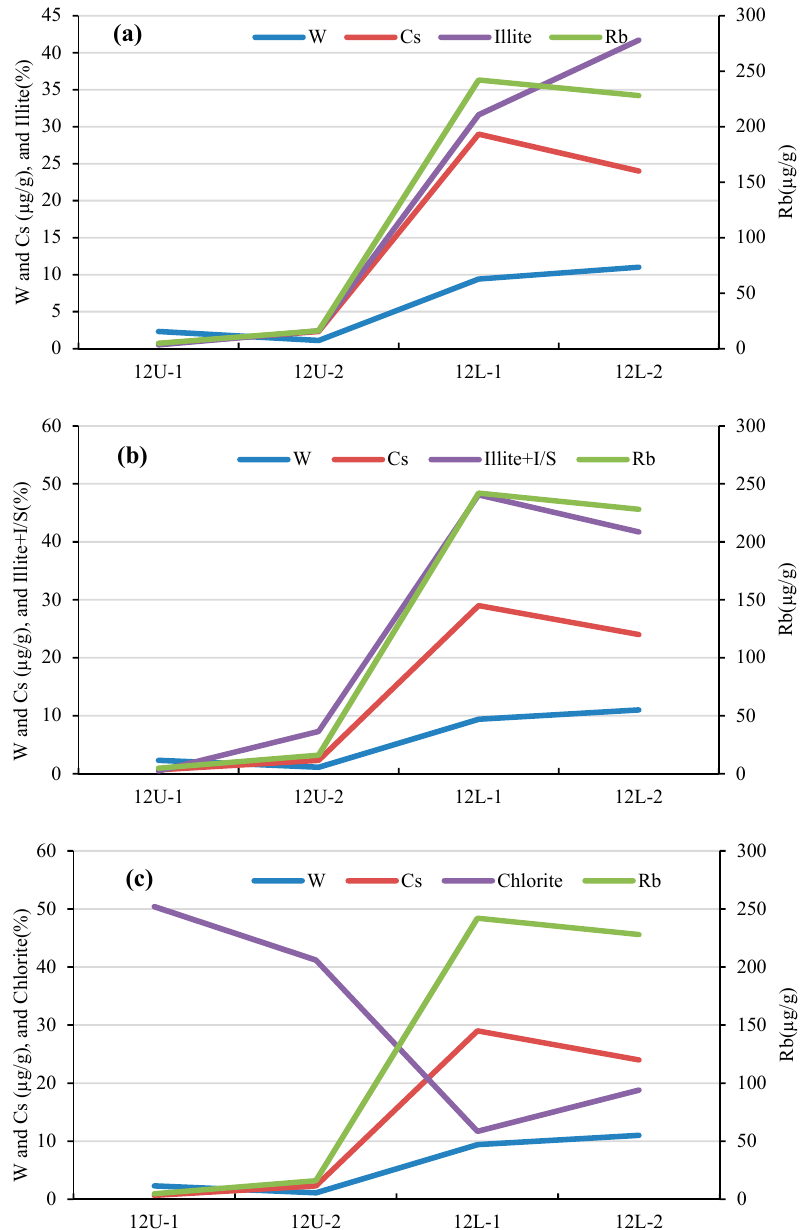
Figure 12. Relationship between W, Rb, and Cs and illite ( a ), illite + I/S ( b ), and chlorite ( c ) in the coals.